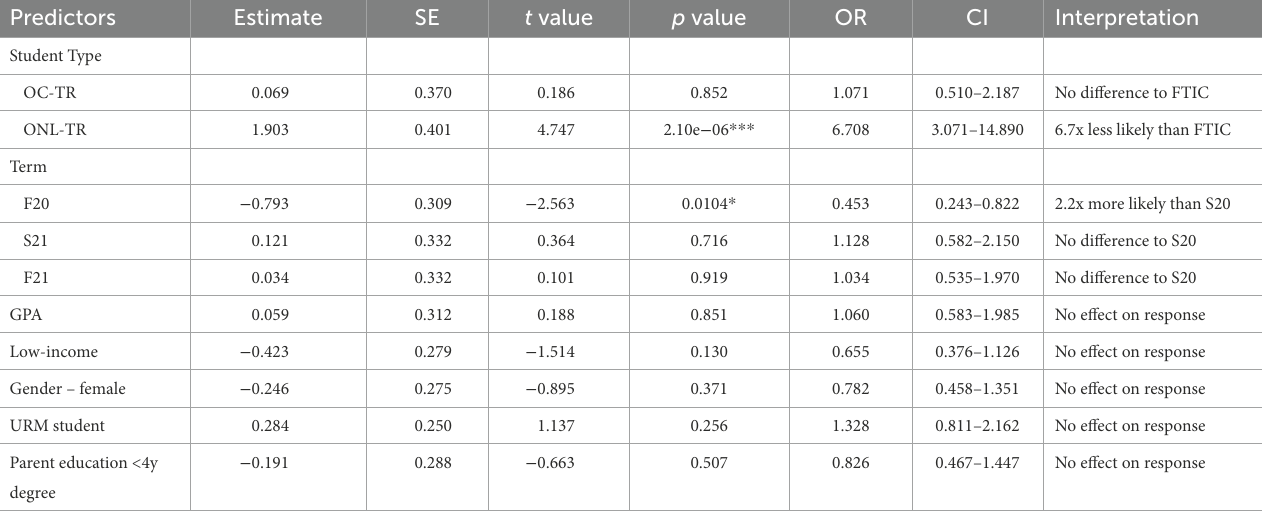
TABLE 1 Estimated coefficients with odds ratios (OR) and CIs from the ordinal regression model that estimated the predicted probability of student responses to the negative impact of the pandemic on their education.